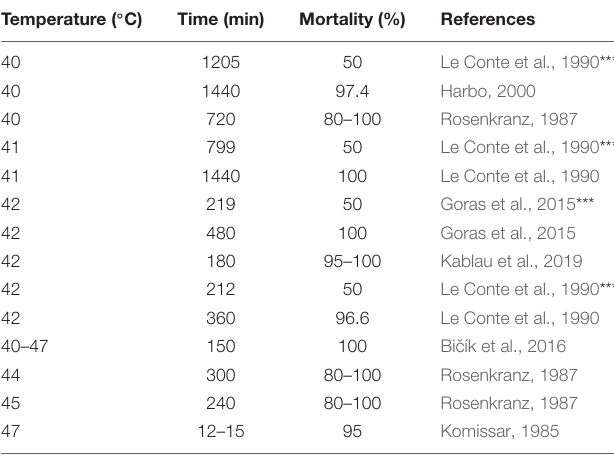
TABLE 3 | Lethal temperatures and times reported for Varroa in the